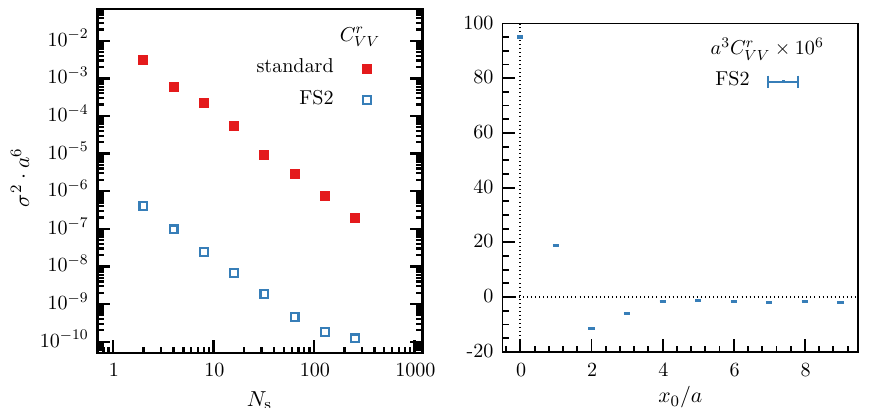
Fig. 7 Left: variance of the disconnected contribution in Eq. (7.2) with x 0 / a = 10 using the standard estimator (red filled squares) versus the numberofsources,andtheFS2estimator(blueopensquares)versusthe number of its evaluations per gauge configuration. Recall each evalua- tion of the FS2 estimator costs approximately 6 times the standard one,